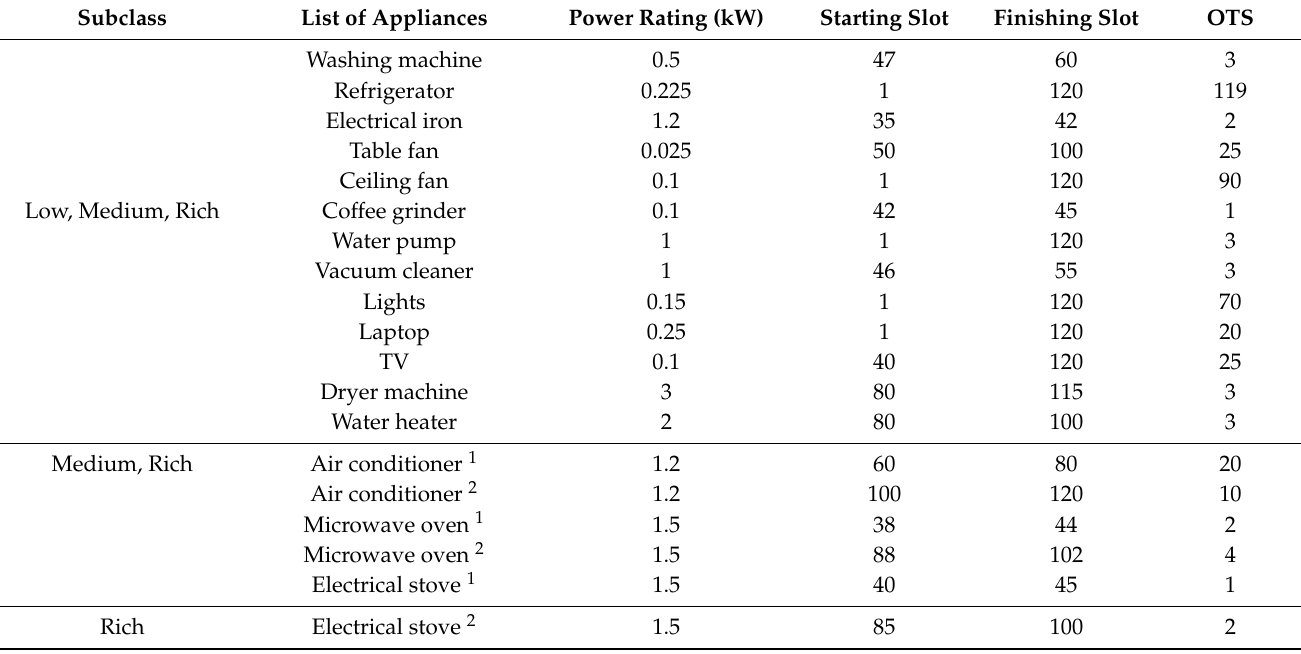
Table 2. Load appliance